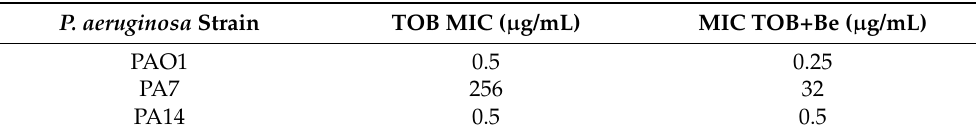
Table 4. Tobramycin (TOB) MIC in the absence/presence of berberine 80 µg/mL (Be) against P. aeruginosa PAO1, PA7, and PA14.